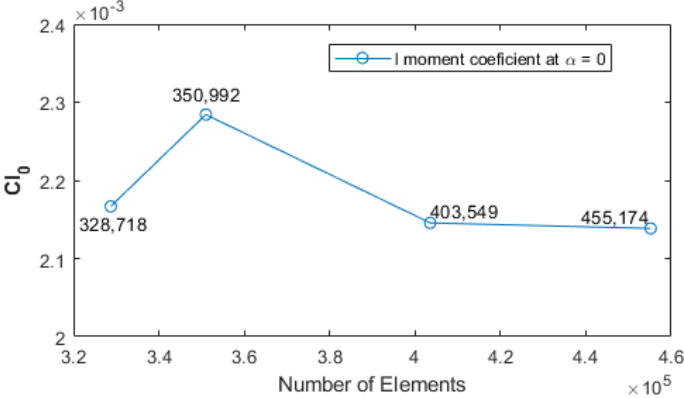
Figure 13. Mesh independence of moment coefficient C l